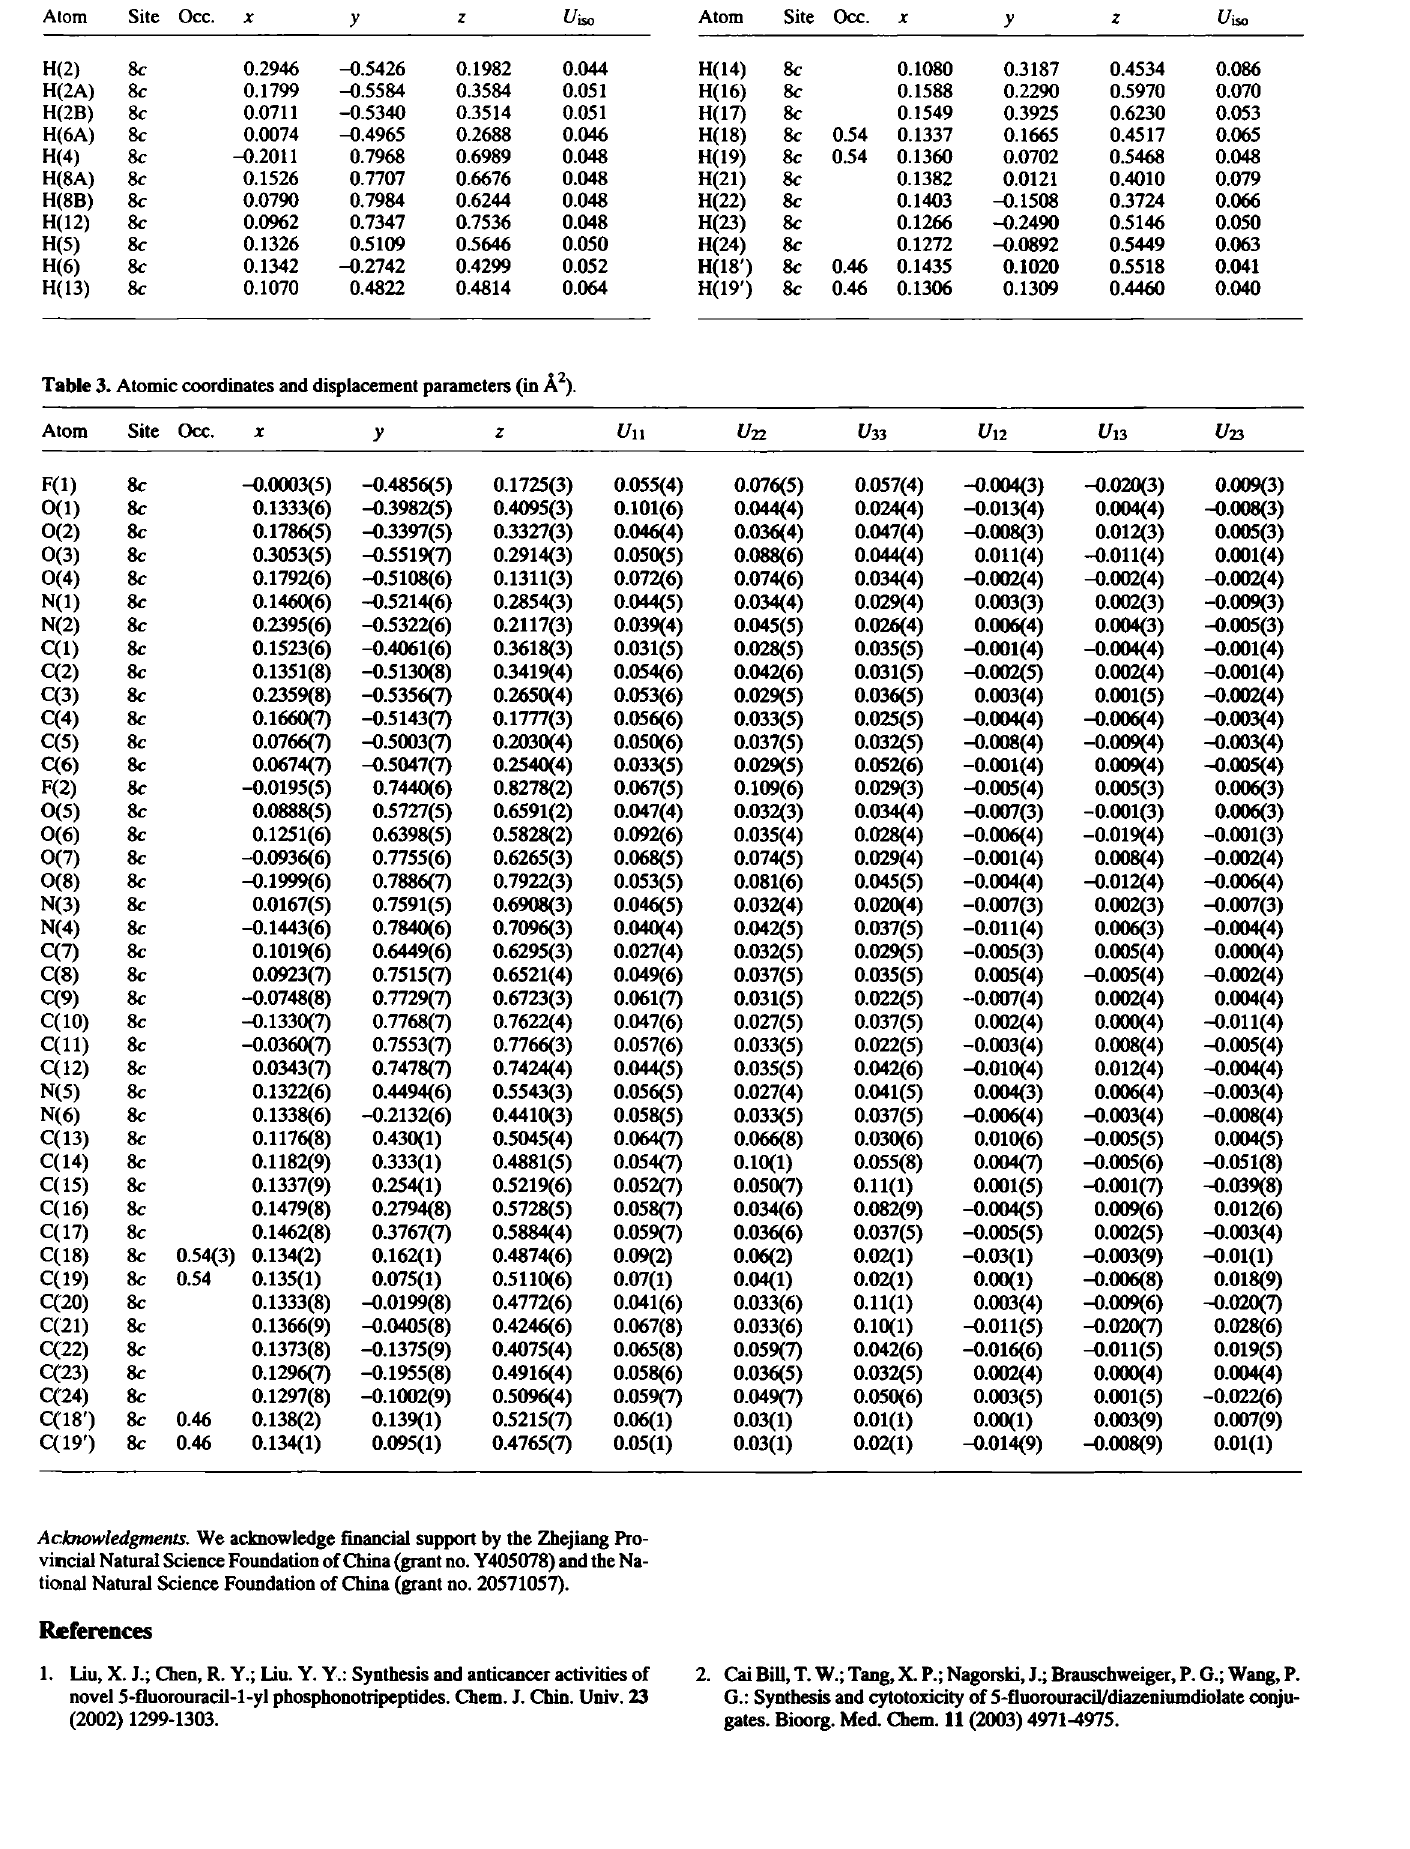
Table 3. Atomic coordinates and displacement parameters (in Ä 2